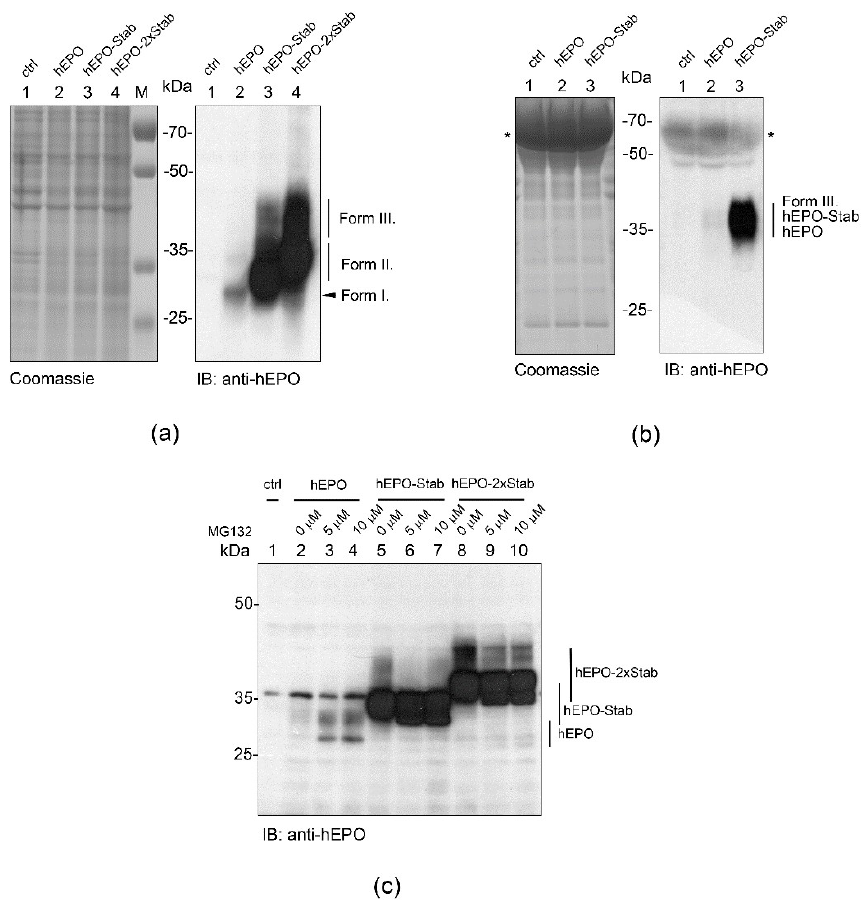
Figure 5. STABILON significantly boosts the intracellular and secreted levels of hEPO in mammalian cells. ( a ) Stably transfected CHO-K1 cells expressing hEPO (lane 2), hEPO-Stab (lane 3) or hEPO-2 × Stab (lane 4) proteins were induced by doxycycline treatment for 24 h. Lane 1 is the control nontransfected cell. Total cell extracts were fractionated on SDS-PAGE. Expression of hEPO derivatives (unmodified and glycosylated forms, Form I–III) was analyzed by immunoblotting using anti-hEPO monoclonal antibody. Coomassie-stained gel shows the protein loading (left panel). ( b ) 10 µ L of cell culture medium of doxycycline-induced control (lane 1), hEPO (lane 2) or hEPO-Stab (lane 3) expressing stably transfected CHO-K1 cells were fractionated on SDS-PAGE. Secreted hEPO glycosylated species (Form III) were analyzed by immunoblotting. Coomassie-stained gel serves as loading control (left panel). Asterisk labels the extremely abundant serum albumin present in the medium. ( c ) Stable transfected CHO-K1 cells expressing hEPO, hEPO-Stab or hEPO-2 × Stab were induced with doxycycline treatment for 5 h, then continued for an additional 5 h in the presence of 0 µ M (lanes 2, 5 and 8), 5 µ M (lanes 3, 6 and 9) and 10 µ M (lanes 4, 7 and 10) of MG132. Accumulation of hEPO derivatives was analyzed in total cell extracts by immunoblotting. Protein extracts of CHO-K1 cells served as control (lane 1).